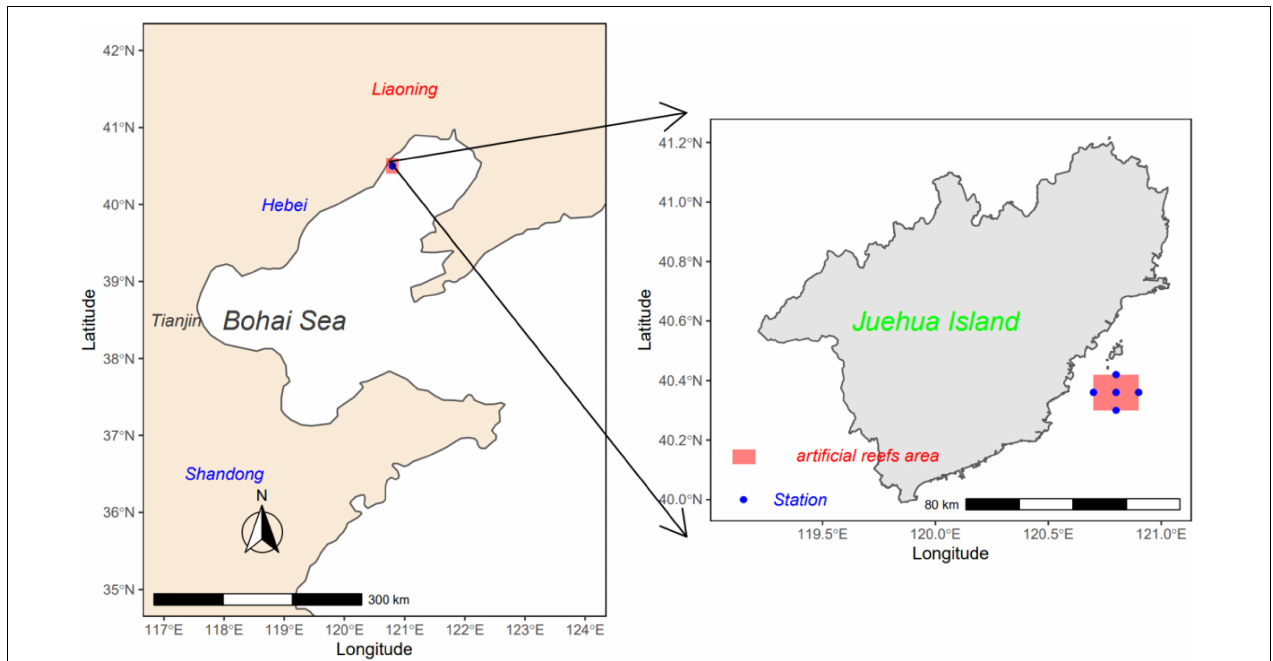
FIGURE 1 | Monitoring stations in the artificial reef ecosystem near Juehua Island in the Bohai Sea.